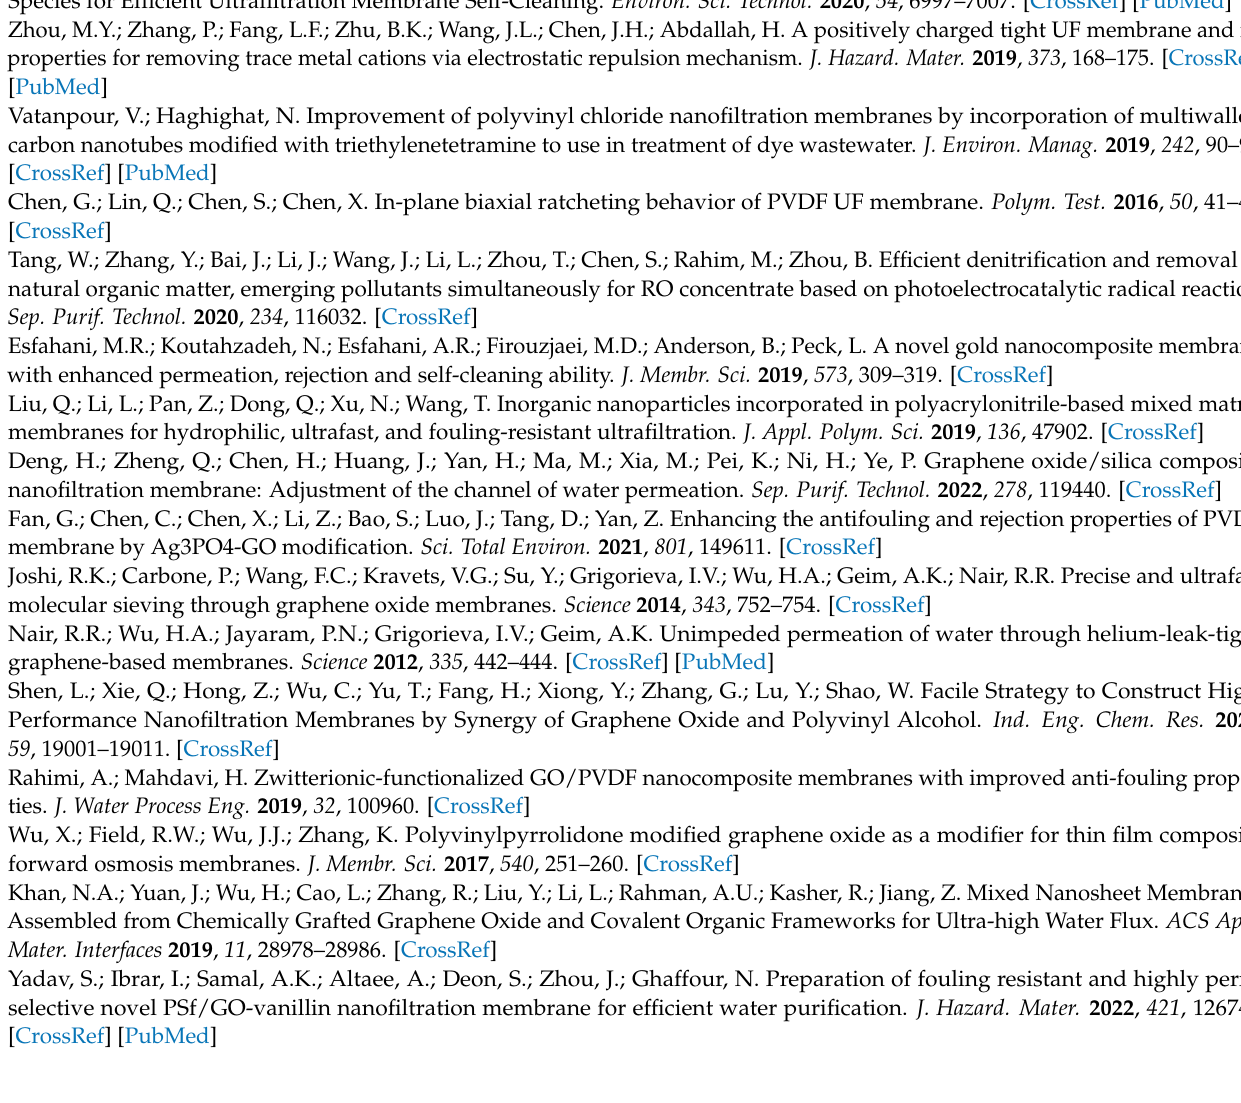
solutions, Table S2: Elemental composition of three membranes’ surface, Table S3: Carbon chemical bond composition of three membranes’ surface, Table S4: Average pore size and porosity of fouled membranes, Table S5: Infrared absorption peaks with corresponding chemical